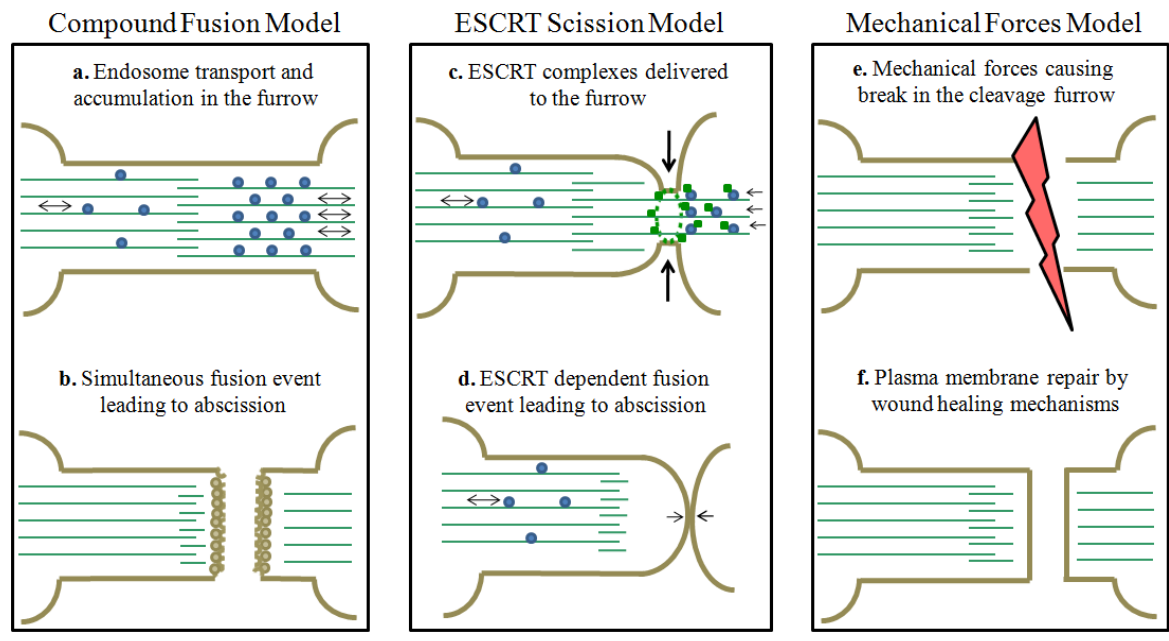
FIGURE 1. Models for cellular abscission. Brown, plasma membrane; light green, microtubules; blue, vesicles; dark green, proteins/lipids required for abscission. The top panels of each model (a,c,e) display earlier cytokinesis events, while the bottom panels (b,d,f) display late cytokinesis events. (a,b) Compound fusion model. (a) Post-Golgi and/or recycling endosomes are delivered and accumulate within the intracellular bridge. (b) Synchronous compound fusion leads to abscission. (c,d) ESCRT scission model. (c) Recycling endosomes are trafficked to the intracellular bridge delivering their membrane and cargo, possibly ESCRT proteins, leading to an ESCRT-dependent narrowing of the plasma membrane and disassembly of microtubules. (d) ESCRT-mediated scission event–based abscission. (e,f) Mechanical forces model of abscission. (e) Traction-based adhesion forces pull daughter cells apart, rupturing the intracellular bridge. (f) Plasma membrane repair through wound-healing